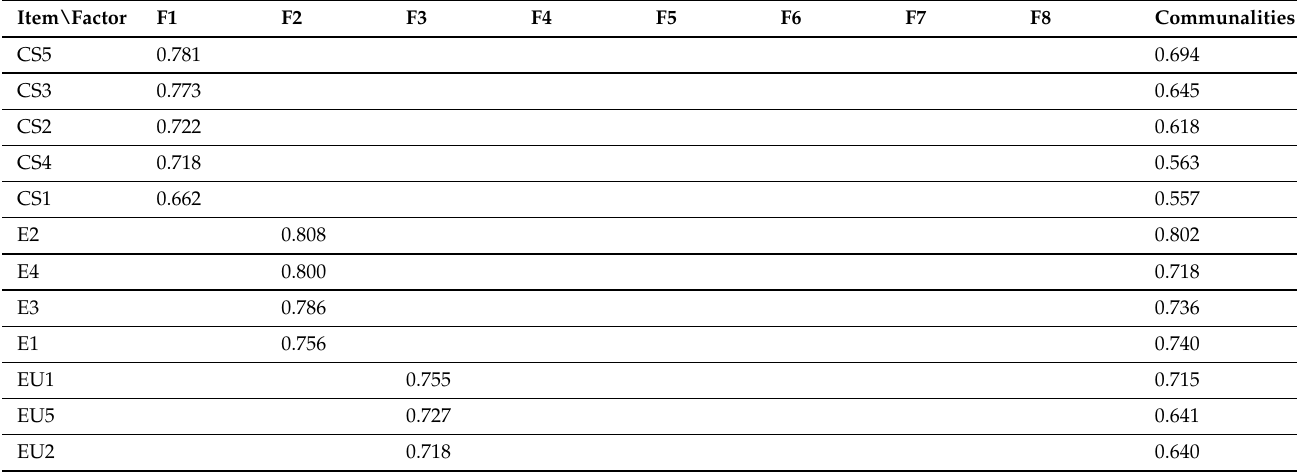
Table 4. Eight-factor model of customer